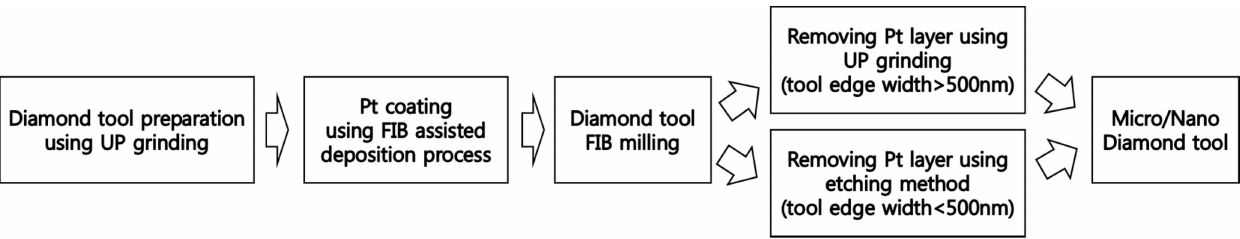
Figure 8. Block diagram of micro/nanoscale diamond cutting tool FIB milling